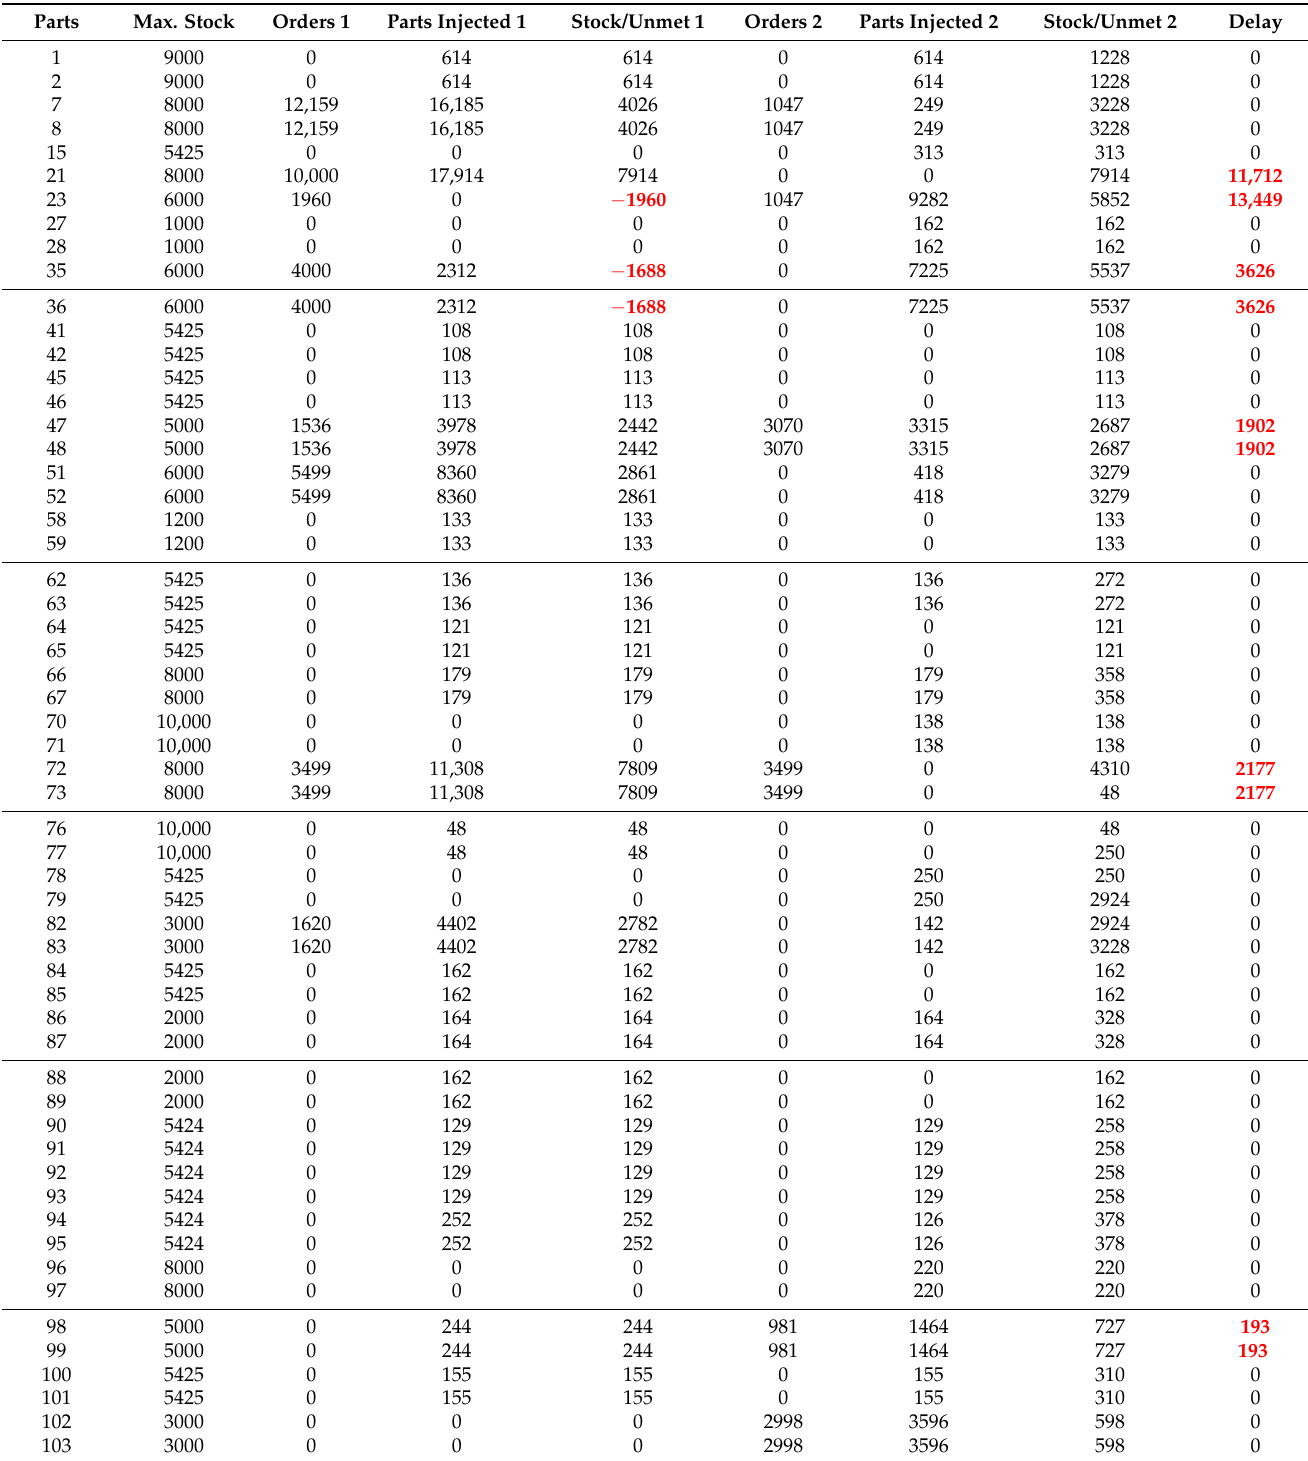
Table 2. Optimal solution